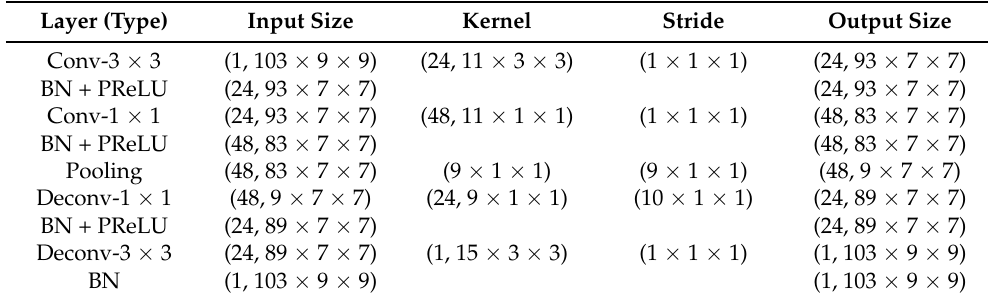
Table 3. Parameter settings of the proposed 3D-CAE model when applied to the Pavia Univer- sity